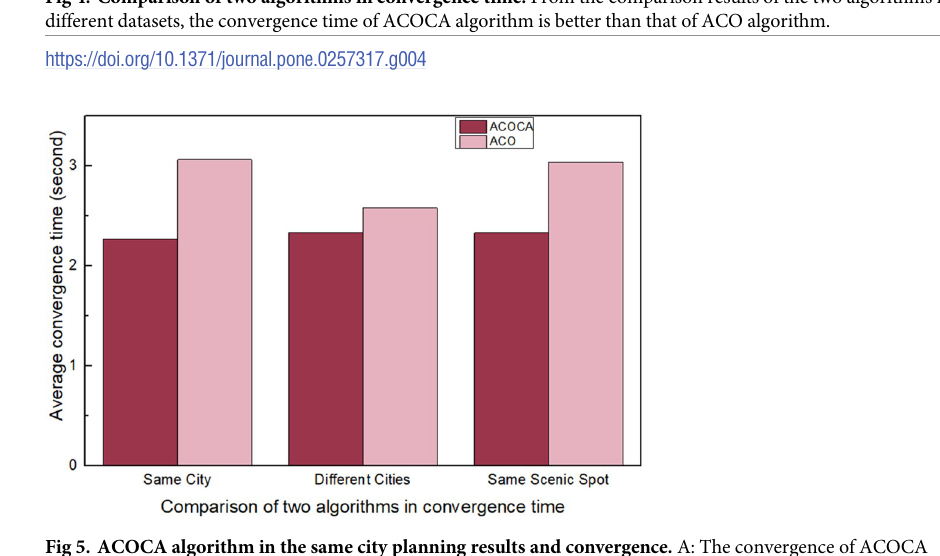
Fig 5. ACOCA algorithm in the same city planning results and convergence. A: The convergence of ACOCA algorithm. B: The result of ACOCA algorithm.